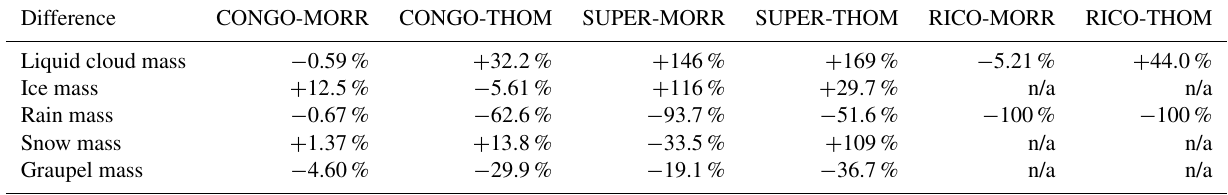
Table 4. Maximum relative difference in the response of model configurations to polluted conditions. The relative change in the